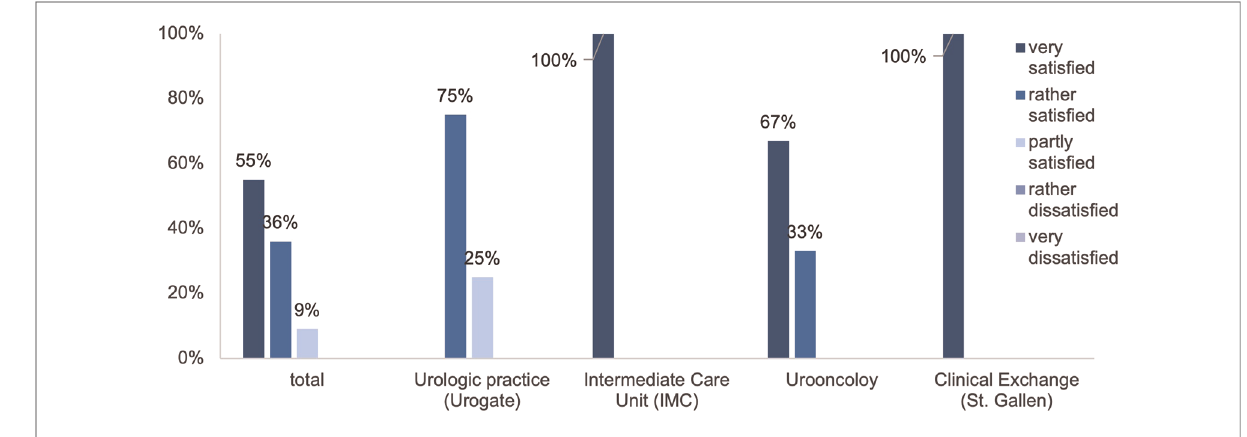
FIGURE 2 Overall satisfaction with the rotation differentiated by the respective rotation ( n